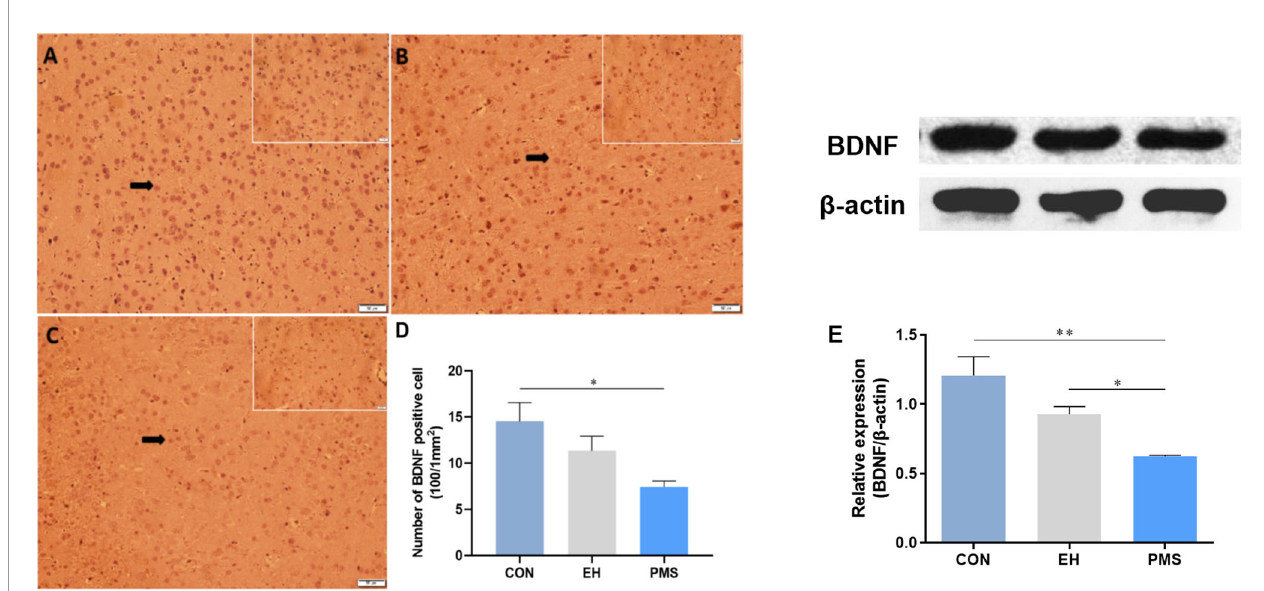
FIGURE 6 | Effects of the PMS and EH procedures on the levels of BDNF protein in the PFC. (A) : The fi gure displays BDNF immunostaining in the PFC from the CON group. (B) : A section of the PFC of the EH group showed the presence of BDNF positively stained cells in the outer layer of the PFC. (C) : The section from rats of the PMS group showed more BDNF positively stained cells in the outer layer of the PFC. Magni fi cation 200× for (A), (B), and (C) , and 400× for the inserts (arrow). (D) : Quanti fi cation of the difference in BDNF positive cells in the PFC between groups. (E) : The Western blot analysis results of BDNF in the PFC samples from the EH, PMS and control (CON) groups. A sample of 30 m g of cellular protein from different rat brain regions was processed for Western blot assays using antibodies against BDNF and b -actin. The Intensity of the immunoreactive protein was measured using the Image J software. Values are expressed as the mean ± SEM (n= 3 rats per group). *p < 0.05, **p <